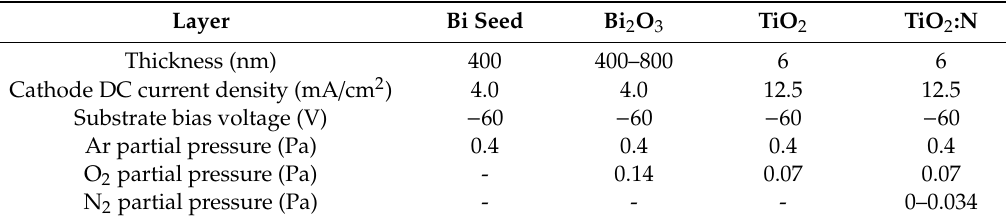
Table 1. Deposition parameters for Bi / Bi 2 O 3 / TiO 2 :N